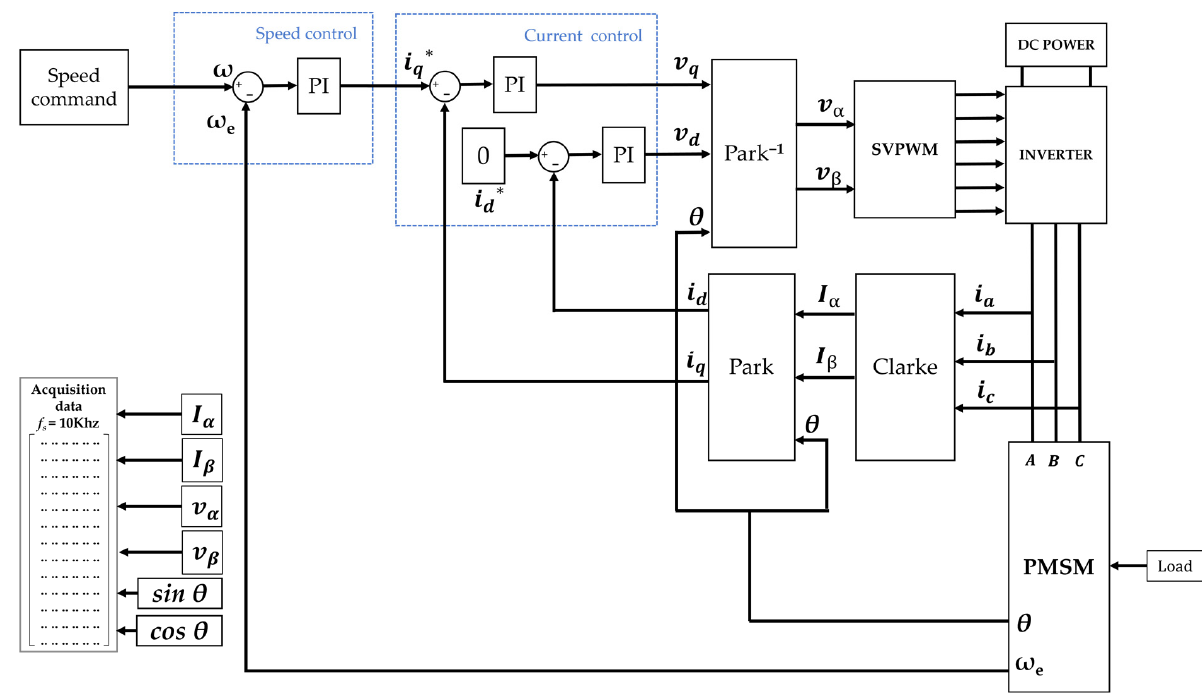
Figure 6. Sensored PMSM control algorithm and data acquisition. Table 2. Types of PMSMs and their parameters.